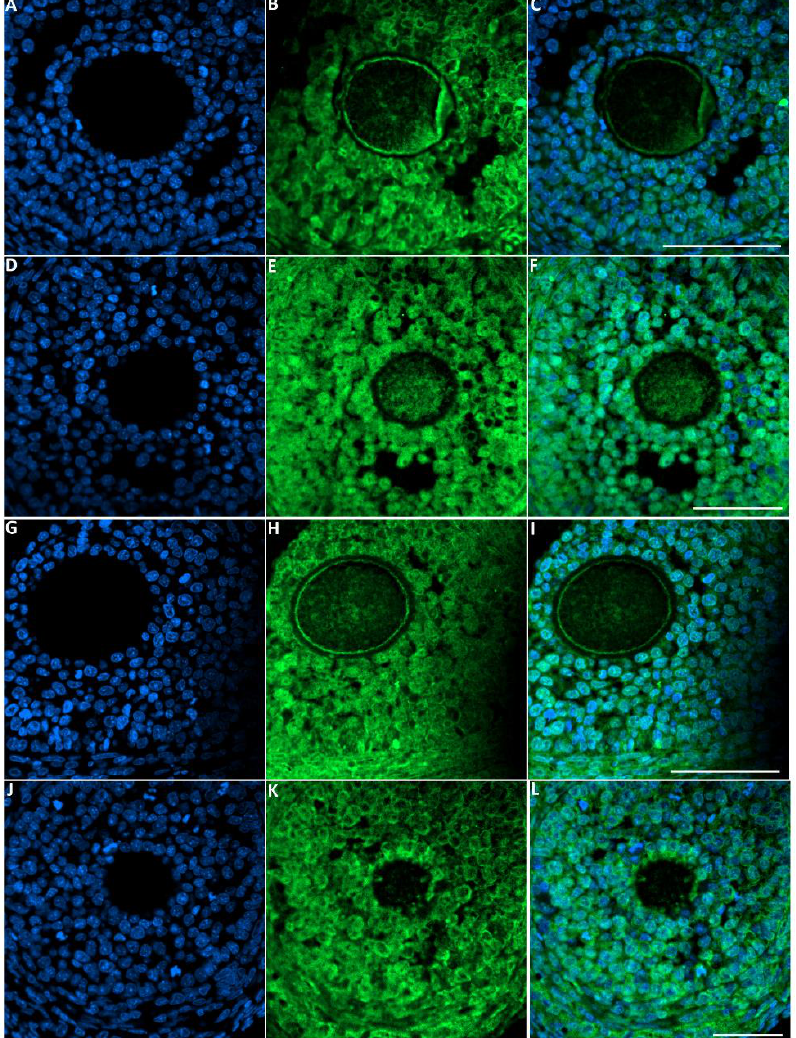
Figure 7. Representative images of LC-3 immunofluorescence staining in female rats that were exposed to toluene compared to the control. Control group ( A – C ), 2000 ppm-treated group ( D – F ), 4000 ppm-treated group ( G – I ) and 8000 ppm-treated group ( J – L ). Scale bars = 100µm.